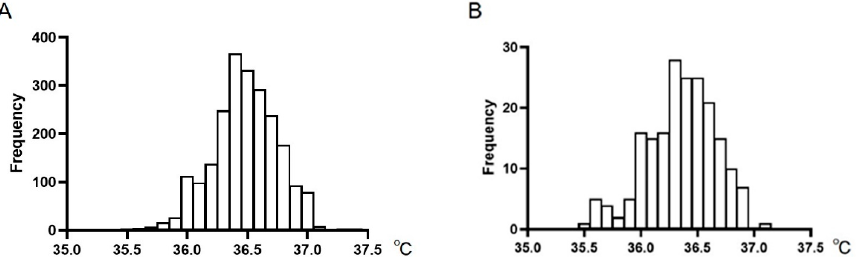
Figure 1. Distribution of the axillary temperature measurements in healthy Japanese male adults ( n = 2258) ( A ) and female adults ( n = 196) ( B ).